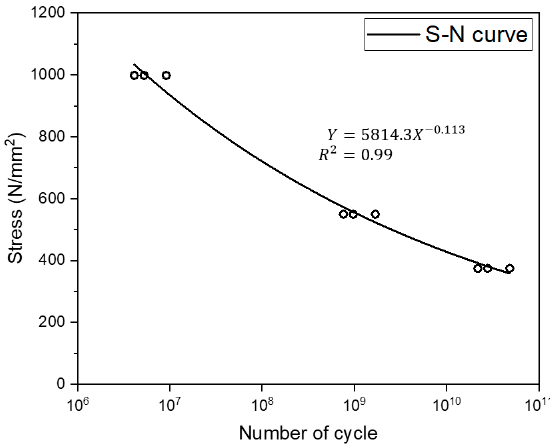
Figure 5. S–N curve of spiral bevel gears obtained based on fatigue life test results presented in previous studies [41].